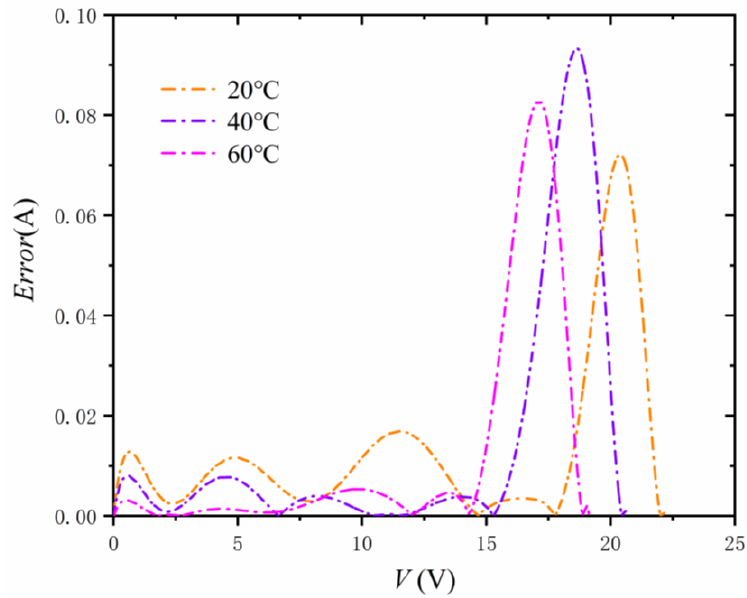
Figure 11. P-V characteristics measured and calculated, respectively. for the thin-film SM55 PV panel in different temperature conditions.